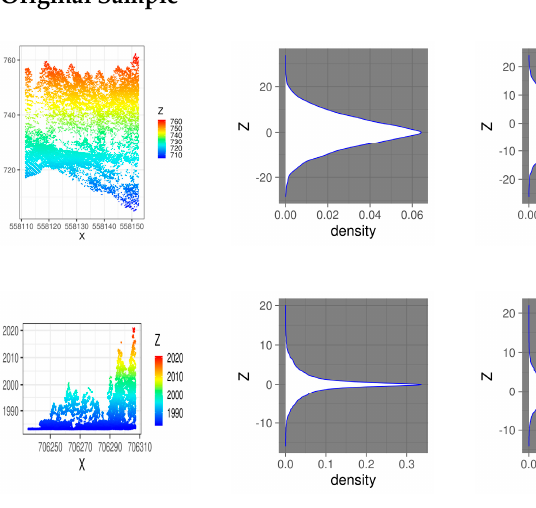
Figure 5. Illustration showing the visualization of the original point set, first three IMFs, and last IMF for the selected Andrews 1 and Tahoe 1 datasets.